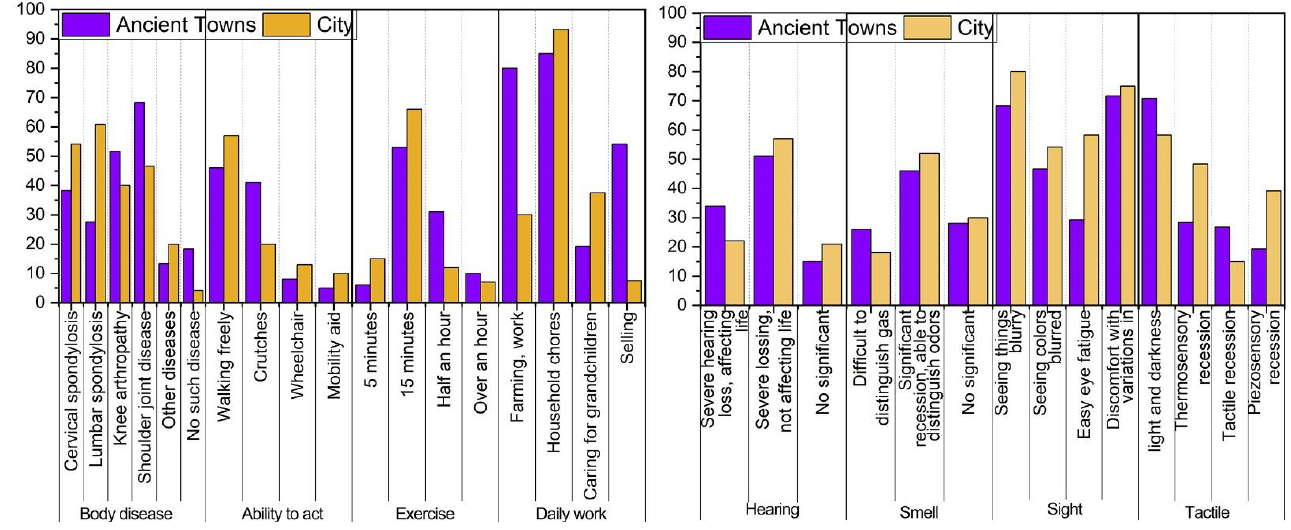
Figure 7. Physiological characteristics and sensory characteristics of the elderly in ancient towns.